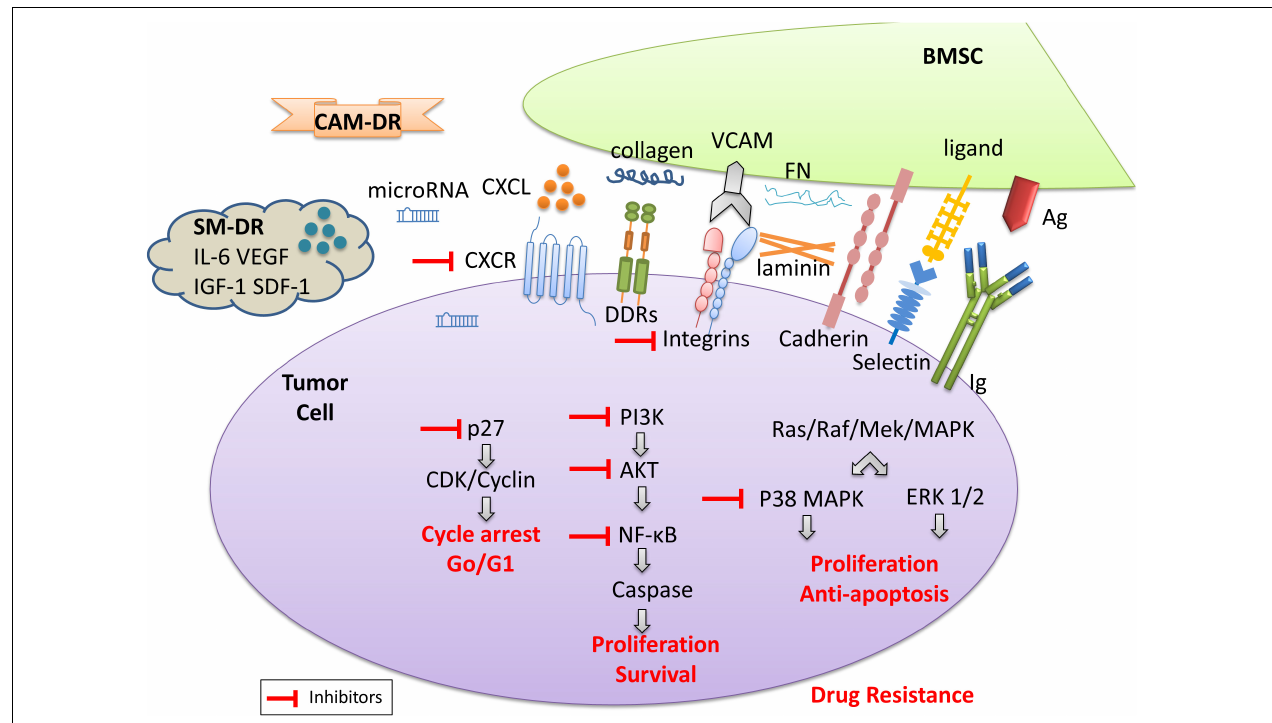
FIGURE 1 | The model diagram of the tumor microenvironment. The cross-talk between tumor cells and stromal cells is regulated by different mechanisms: (i) cell-to-cell adhesion between tumor cells and ECM components (i.e., collagens, fibronectin, and laminin)/stromal cells; and (ii) soluble factors, i.e., cytokines, chemokines, growth factors, exosomes, and miRNAs released by the stromal cells and MM cells, with autocrine and paracrine effects. The adhesion of tumor cells and stromal cells is associated with cell surface antigen and antibodies, the expression of the integrin family, discoidin-domain receptors (DDR), cadherin, selectin, etc. As shown here, collagen and other proteins are involved in CAM-DR, while soluble cytokines are usually involved in SM-DR. They contribute to drug-resistance upon engagement with their ligands in the tumor microenvironment. The activation of the signaling pathways involved leads to tumor cell proliferation, anti-apoptosis, and survival, resulting in drug resistance. Inhibitors of related signaling pathways are beneficial to the reversal of drug